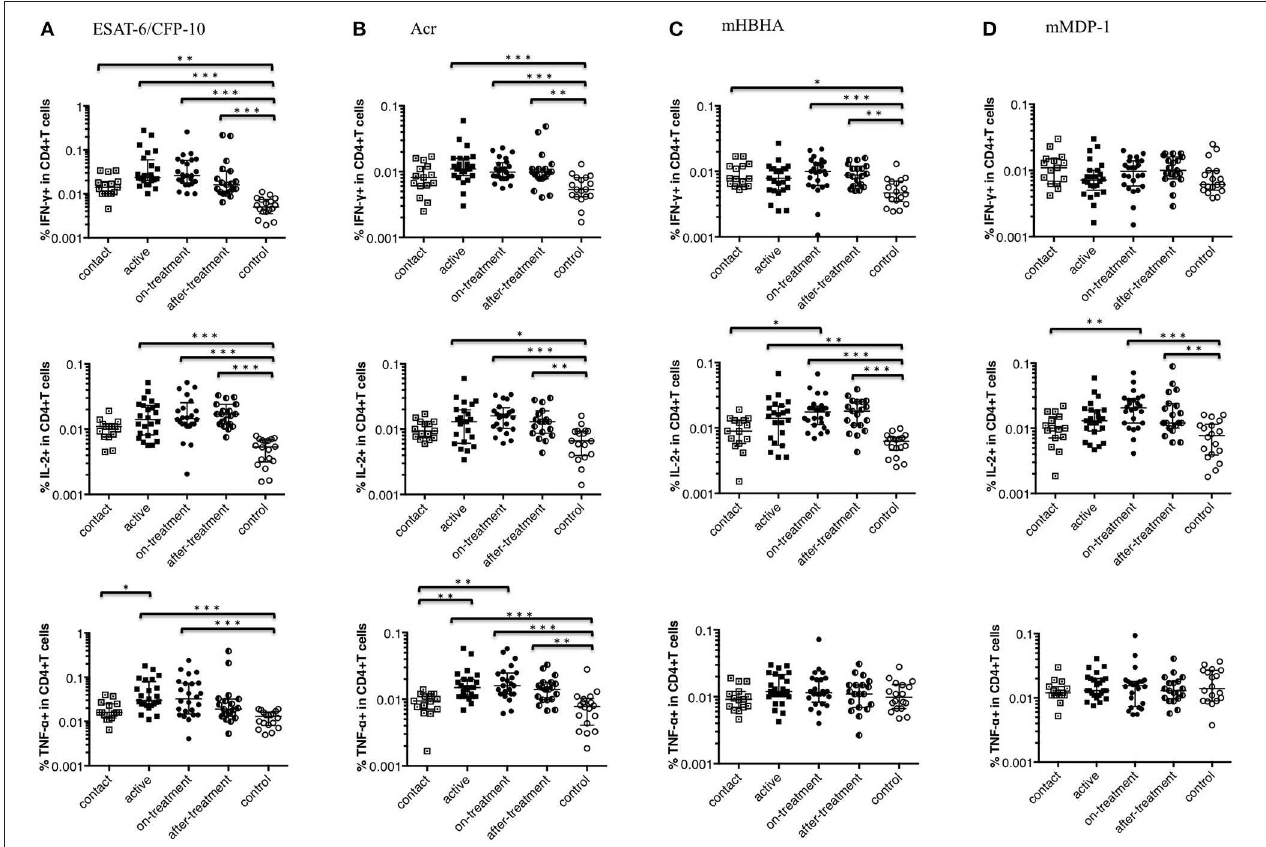
FIGURE 1 | Th1 cytokine (IFN- γ , IL-2, and TNF- α ) responses of CD4 + T cells to M. tuberculosis -associated antigens. Th1 cytokine responses of CD4 + T cells in M. tuberculosis -infected cases, grouped according to the disease stage as active TB cases ( n = 24), on-treatment TB cases ( n = 24), after-treatment TB cases ( n = 19), and contact cases ( n = 15). Responses of control cases ( n = 18) are also shown. The differences between each set of samples were assessed using the Kruskal-Wallis test and post-hoc Dunn’s Comparison test (* P < 0.05, ** P < 0.01, *** P < 0.001). The long horizontal line represents the median and the vertical line represents the interquartile range. (A) Th1 cytokine responses to ESAT-6/CFP-10 (One data point is outside the limits in IFN- γ , and also one data point is outside the limits in IL-2). (B) Th1 cytokine responses to Acr (Three data points are outside the limits in IL-2). (C) Th1 cytokine responses to methylated (m) HBHA (Two data points are outside the limits in IL-2). (D) Th1 cytokine responses to